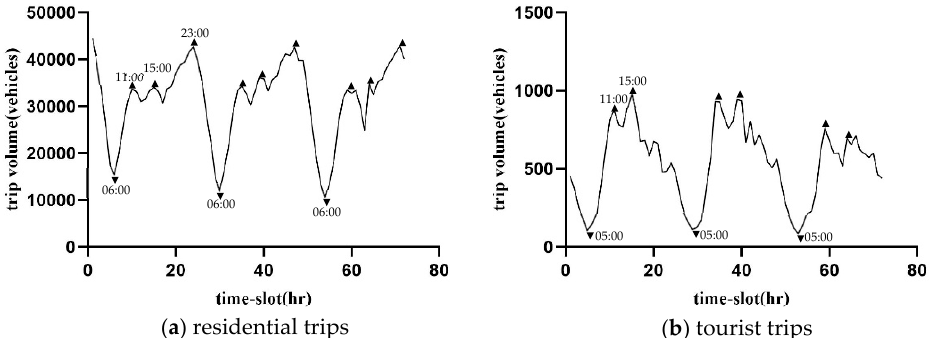
Figure 3. ( a , b ) Hourly traffic volume of residential trips and tourist trips.